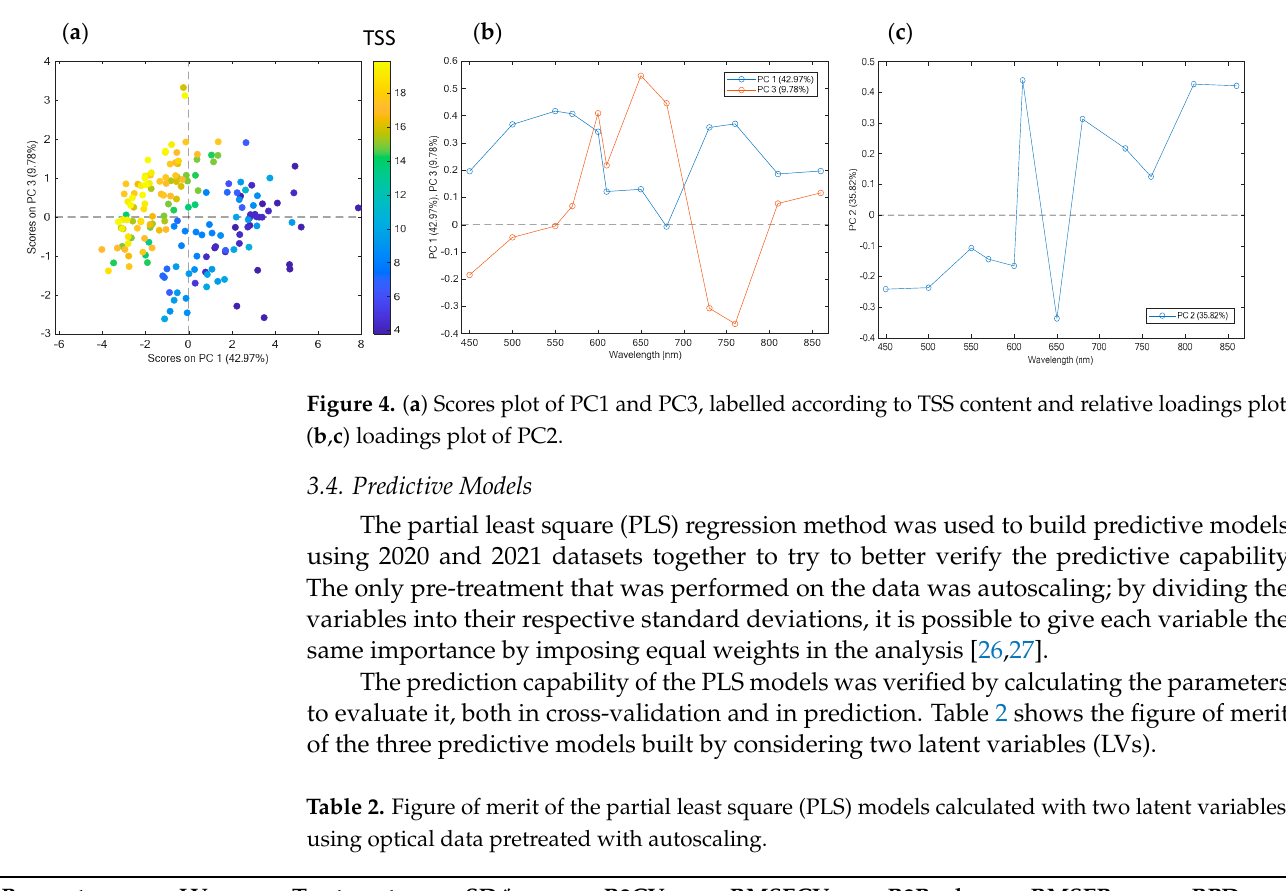
Table 2. Figure of merit of the partial least square (PLS) models calculated with two latent variables, using optical data pretreated with